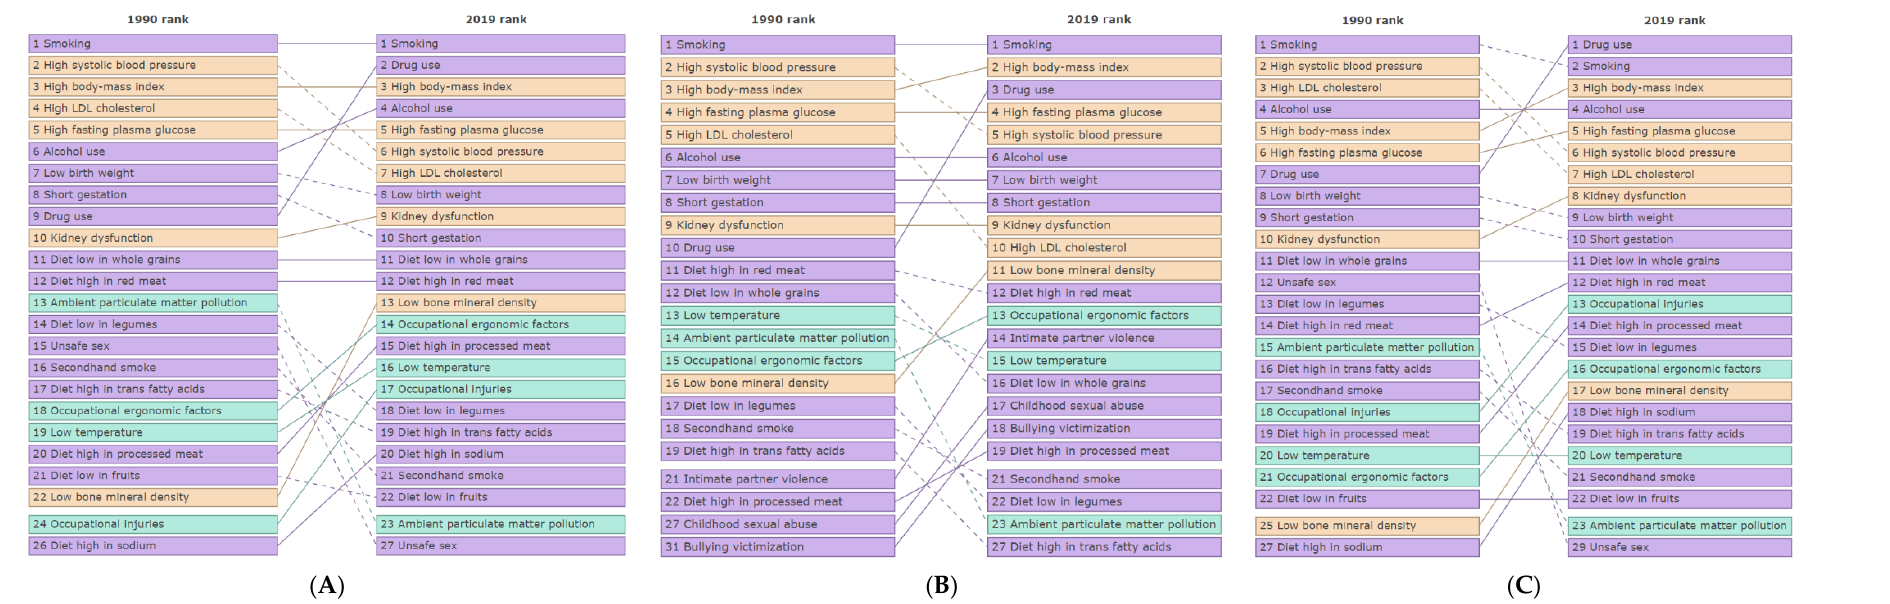
Figure 3. Colorado top risk factors by disability-adjusted life years (DALYs) in ( A ) Both sexes, ( B ) Females, ( C ) Males, Level 4, 1990–2019. Purple rectangles represent behavioral risks; green rectangles represent environmental/occupational risks; and orange rectangles represent metabolic risks. Continous lines represents increase or no change in the rank bewteen years. Dashed line represents decrease in the rank bewteen years. Institute for Health Metrics and Evaluation (IHME). GBD Compare Data Visualization. Seattle, WA: IHME, University of Washington, 2020. Available from http://vizhub.healthdata.org/gbd-compare (accessed on 23 September 2021).